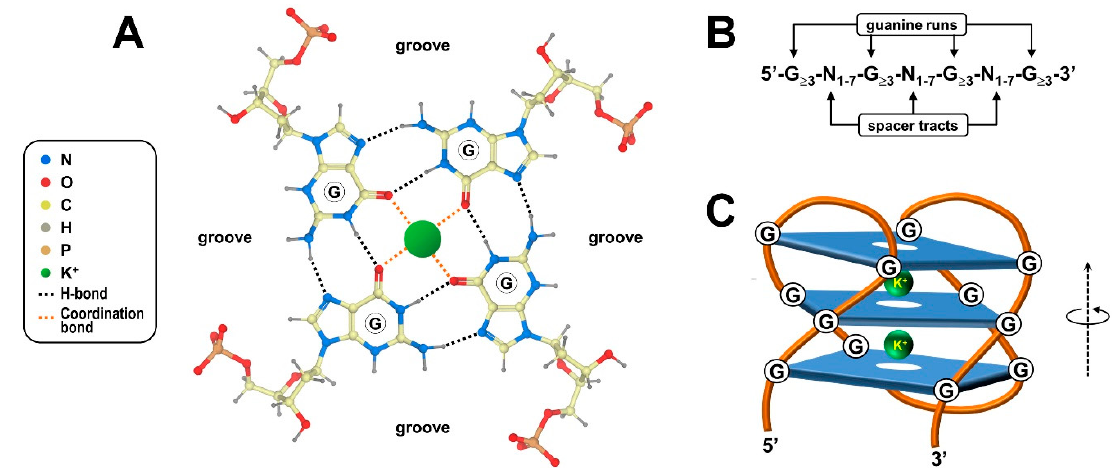
Figure 1. Chemical structures of G-quartet and G-quadruplex. ( A ) Structural arrangement of the G-quartet, highlighting the hydrogen bonding network between the Hoogsteen and Watson–Crick faces of the coplanar guanine bases. The attached deoxyribose sugars are shown together with a centrally placed metal ion. ( B ) The conventional consensus sequence for a G-quadruplex. ( C ) Side view of the schematic diagram showing an intramolecular antiparallel G-quadruplex formed by the stacking of three G-quartets. Strand polarity and anticlockwise rotation are indicated.